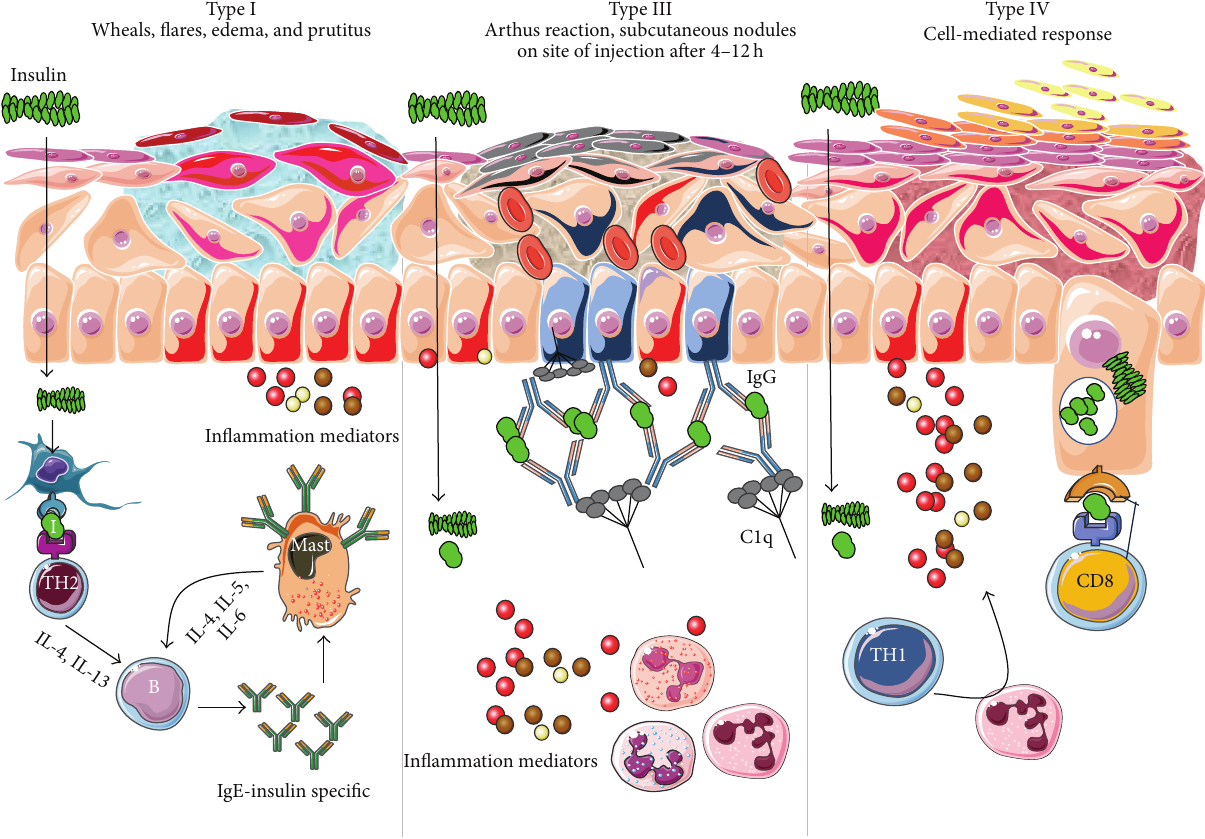
Figure 1: Types of hypersensitivity associated with insulin-related allergy reactions. Type I hypersensitivity reaction is characterized to be a TH2-controlled IgE-insulin specific mediated process, with local edema, itching, wheals, and flares, which could also be associated with angioedema. Type IIIhypersensitivity ismediated by antigen-antibody complex andrecruitment ofcomplement C1q,withsubsequent edema, necrosis, and nodule formation. Finally, Type IV reactions are CD8-cytotoxic specific with subcutaneous edema, itching, and